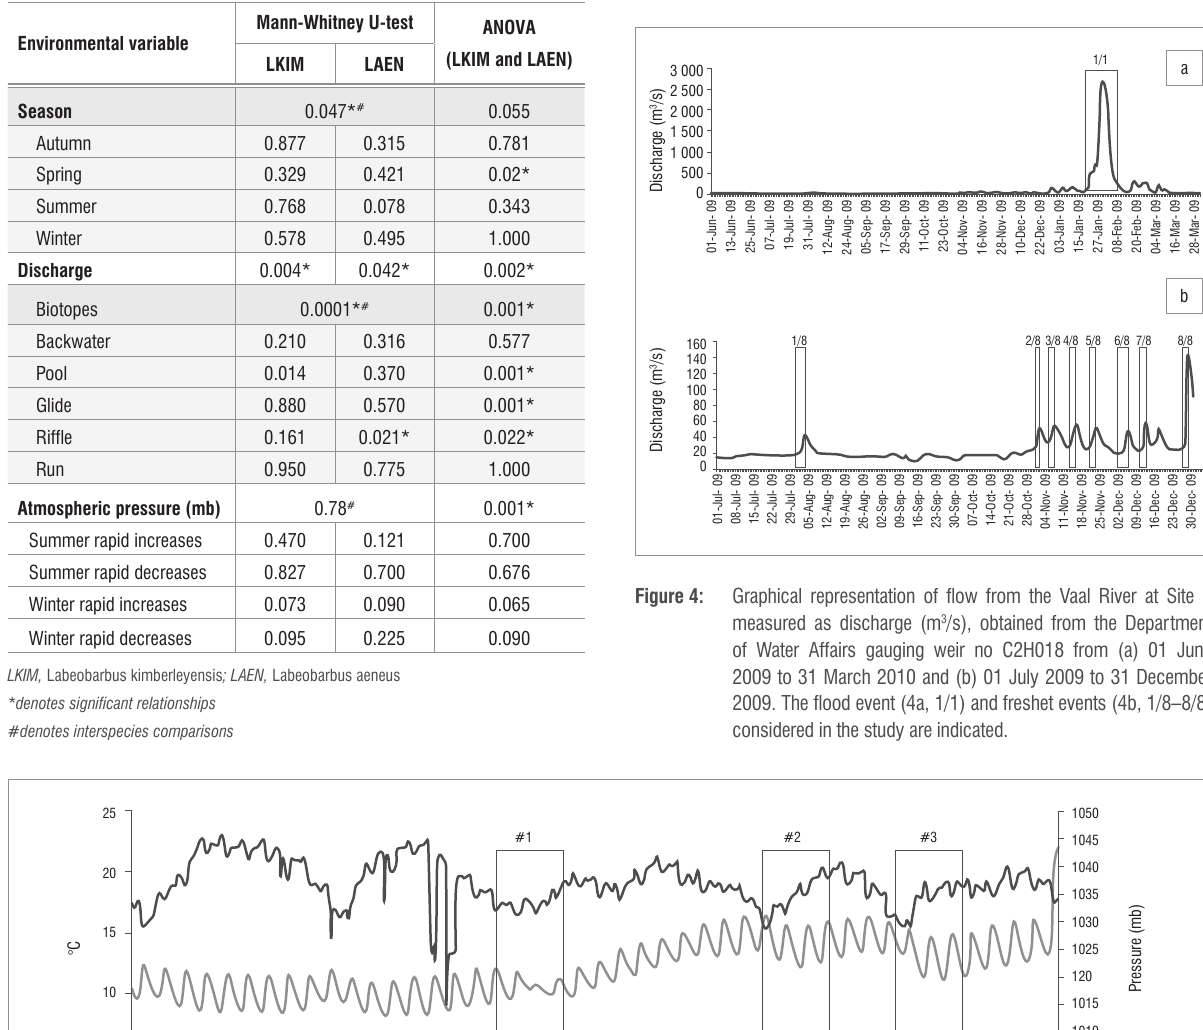
Statistical analysis of the relationships between changes in movement (measured as maximum displacement per minute) of yellowfish in the Vaal River and selected environmental variables using analysis of variance techniques incorporating